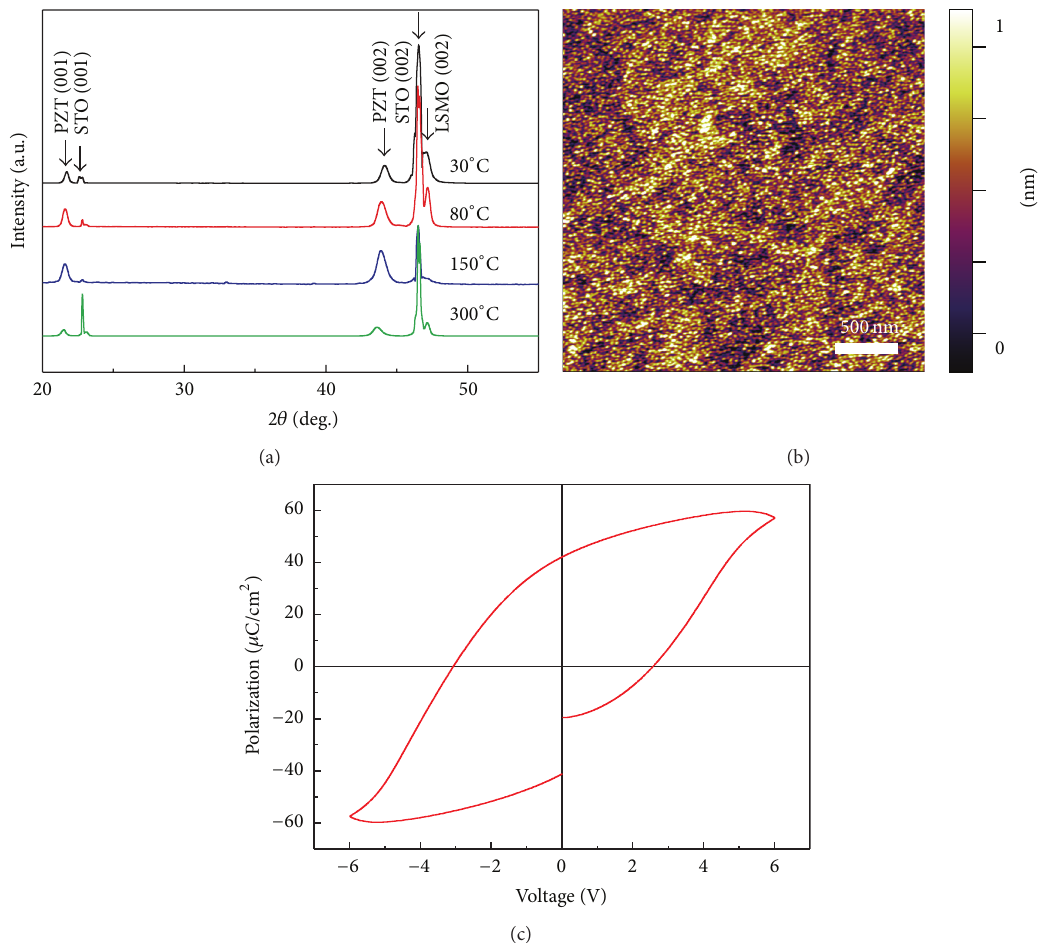
Figure 1: (a) XRD patterns of TiO 𝑥 /PZT/LSMO/STO heterostructures, in which the TiO 𝑥 layers were deposited in 2.0 Pa oxygen at various temperatures from 30 to 300 ∘ C; (b) typical surface morphology of TiO 𝑥 /PZT/LSMO/STO heterostructures; (c) hysteresis loop of a 50 nm thick PZT